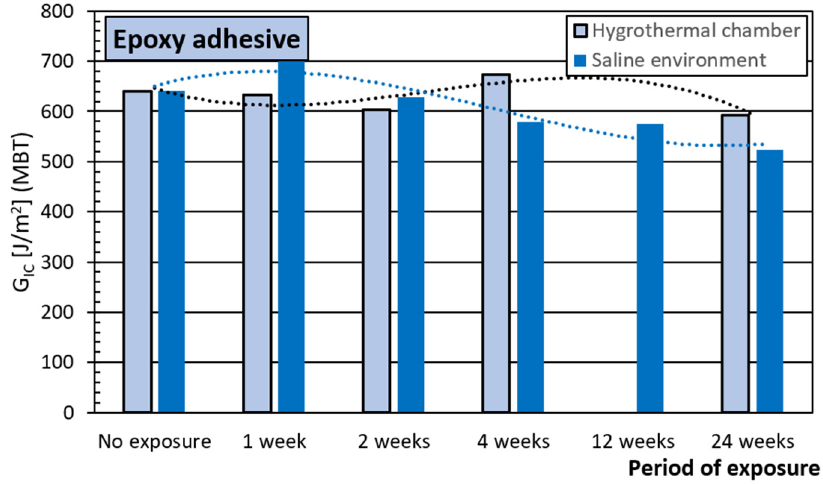
Figure 9. Energy release rate evolution under mode I of the epoxy adhesive, comparison between saline and hygrothermal stresses.